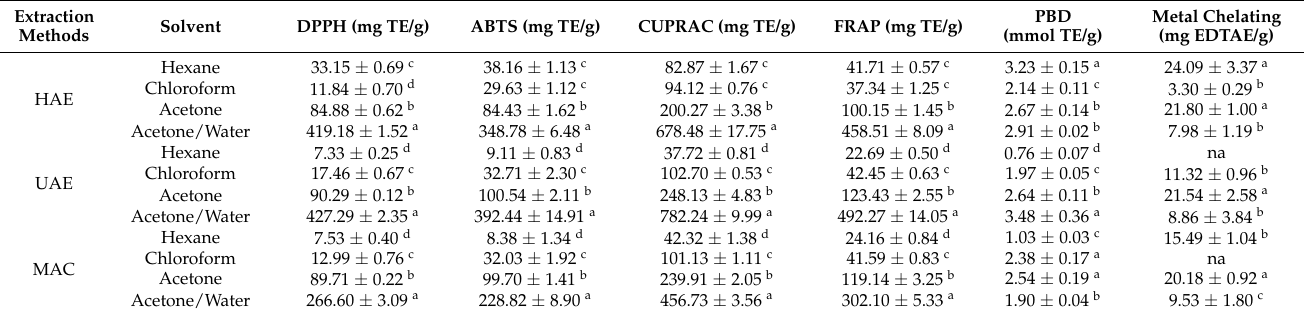
Table 4. Antioxidant properties of the tested extracts